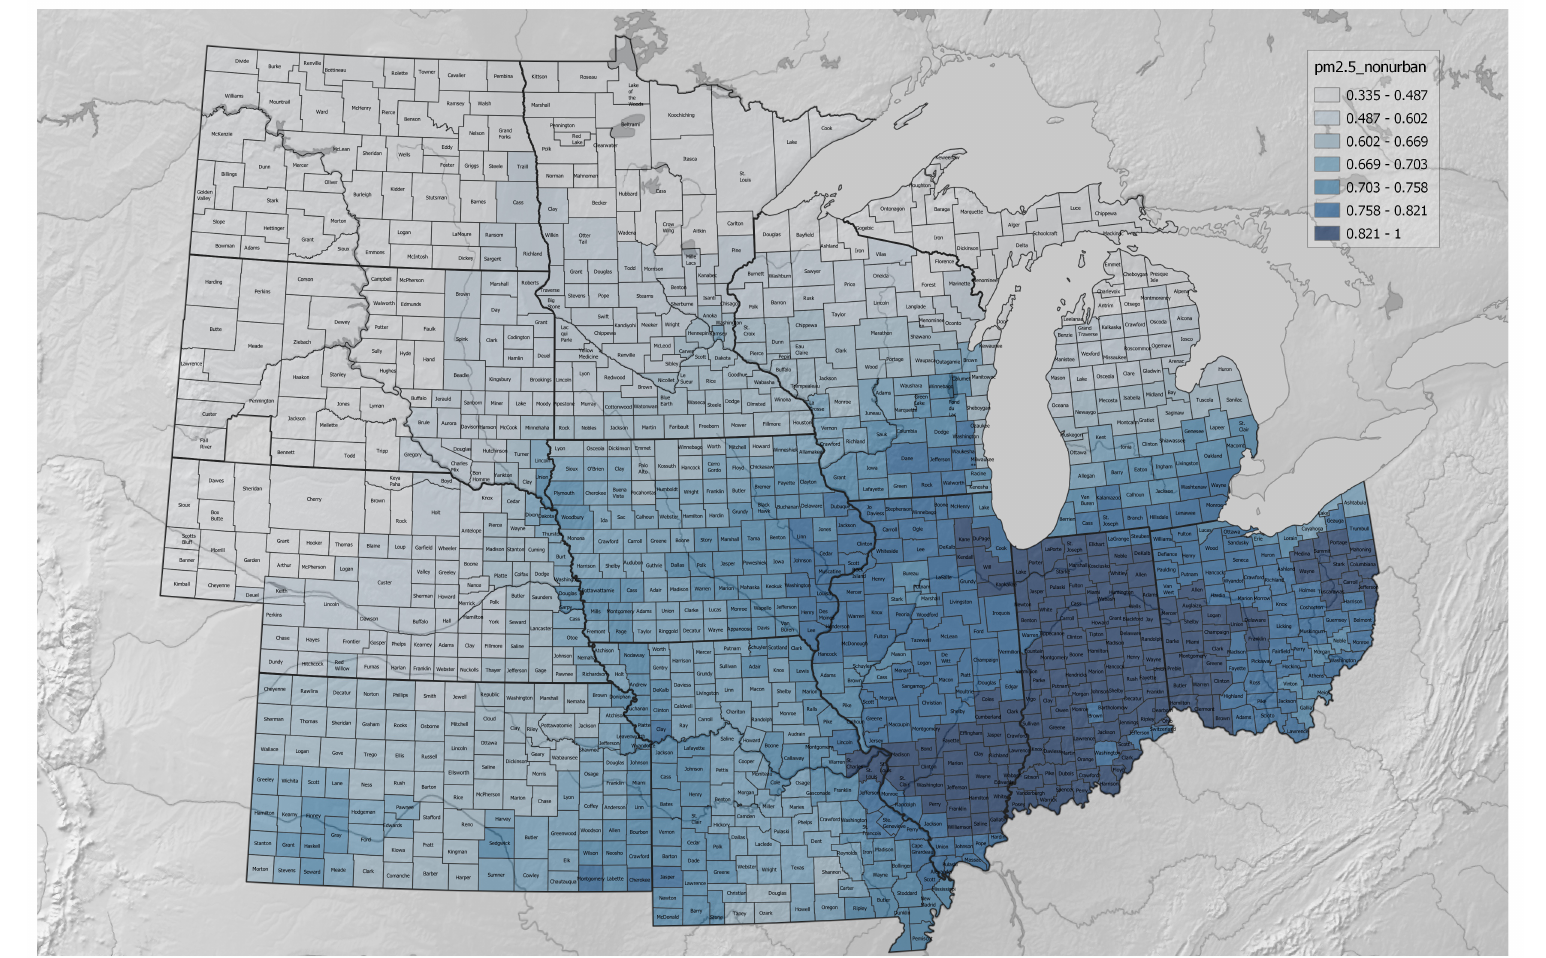
Figure A11. Average nonurban PM 2.5 , by county, 2016. Values were all rescaled through dividing by the largest value present for any of the counties included here (9.410 µ g/m 3 in Porter County, Indiana), as this transformation was applied to the variable data as they were placed into the index expression. Methods for PM2.5_nonurban are described in the article main text and Supplementary Materials. The map is based on data from WHO’s DIMAQ model estimates